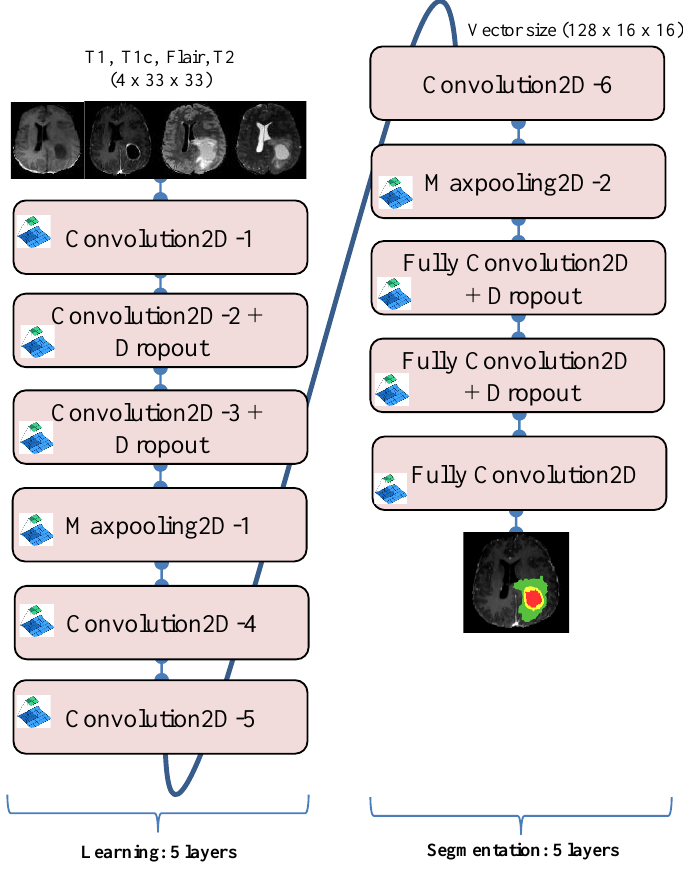
Figure 5. Structureof transfer learning and the segmentation CNN